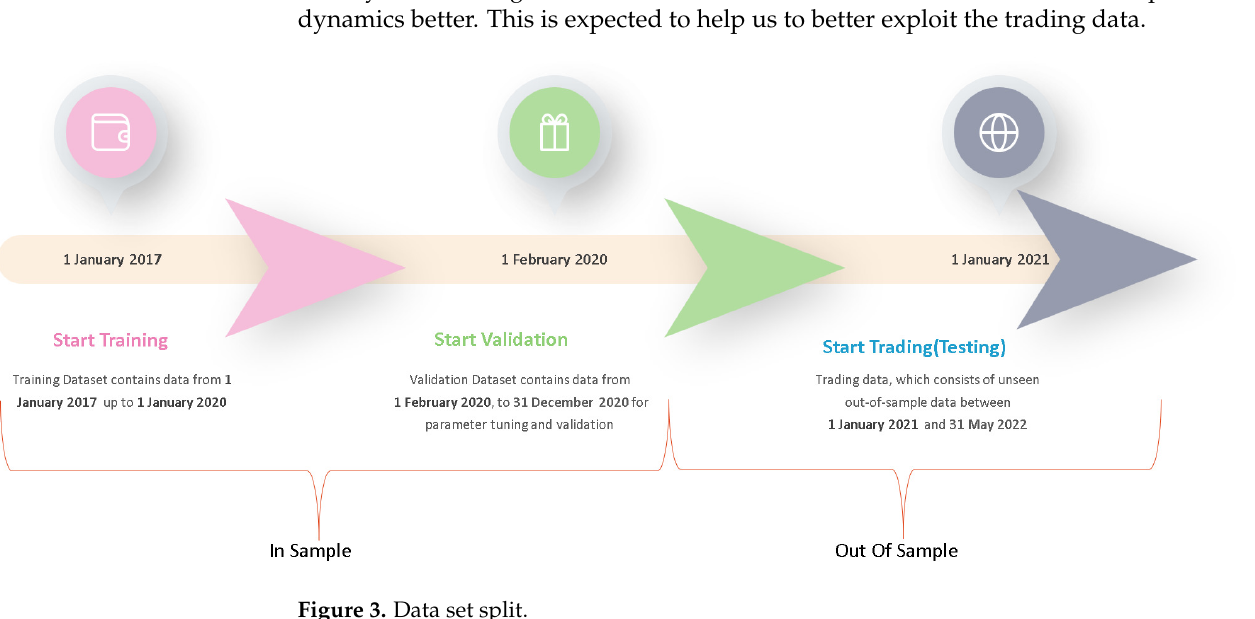
Figure 3. Data set